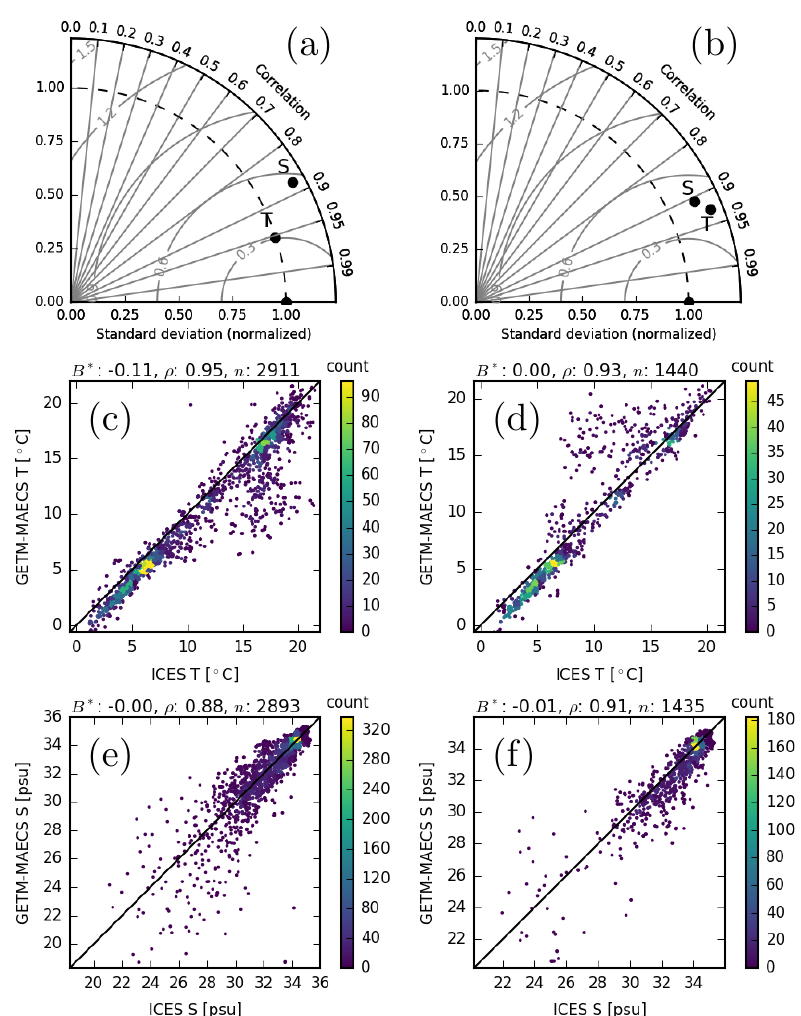
Figure 4. Comparison of modeled and measured (ICES) temperature (abbreviated T in panels a, b, c, d ) and salinity ( S in a, b, e, f ) at the surface (left) and bottom (right) layers for the period 2006–2010. The 2-D histograms show the number of occurrences of simulation– measurement pairs. The normalized bias ( B ∗ ), Pearson correlation coefficients ( ρ ) and corresponding number of data points ( n ) are shown on top of the scatter